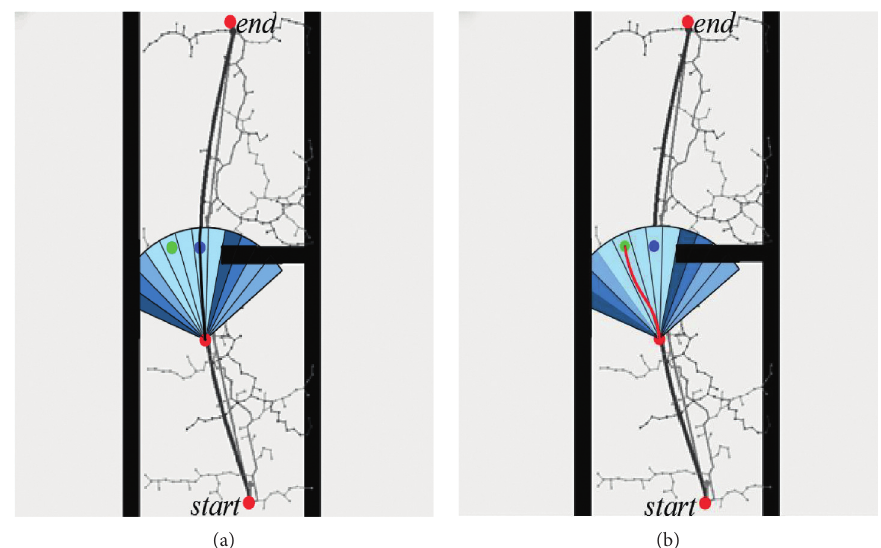
Figure 19: The main steps of low-level path planning methods.